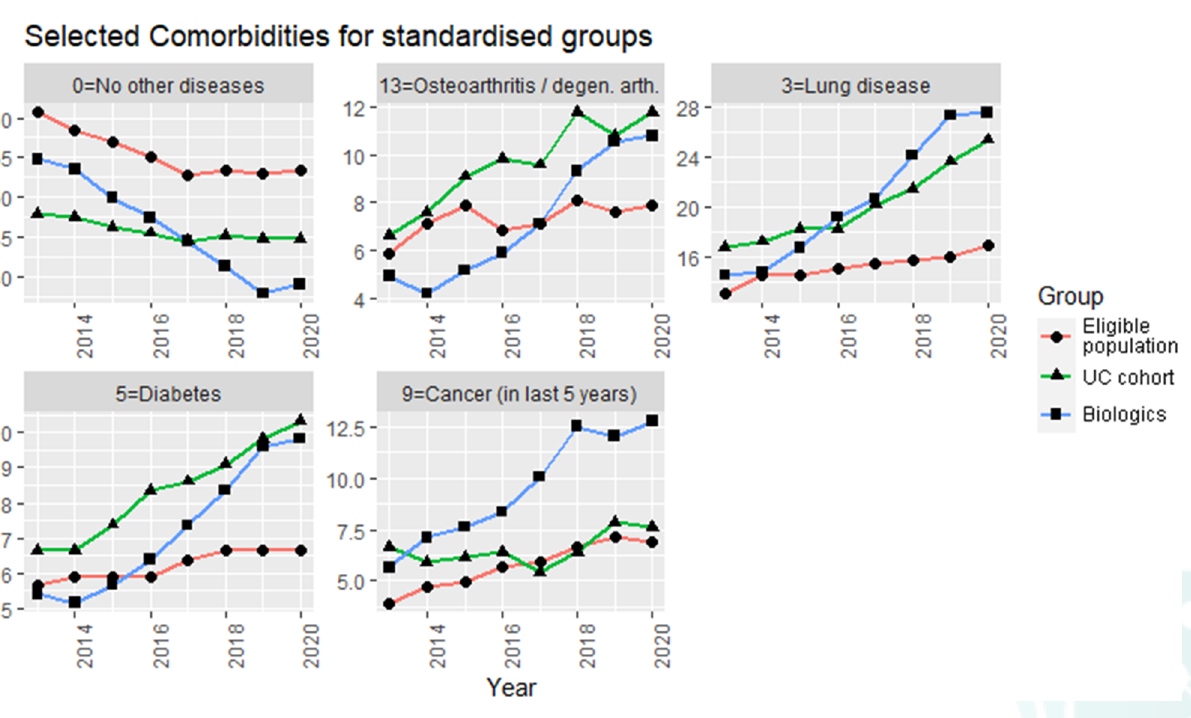
Figure 3: Trends in comorbidity rates for the three age and Health Board standardised patient groups, for the presence of comorbidities in the preceding year (5 years for cancer). The year on the x-axis represents the year a condition is recorded as